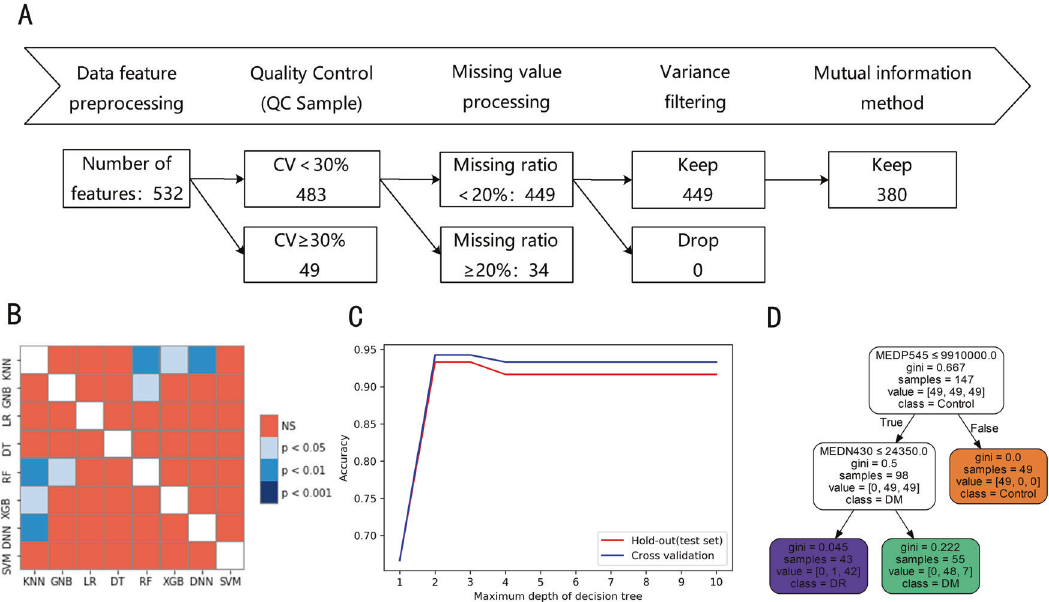
Fig. 1 Data preprocessing and selection of machine learning models. Metabolomic data preprocessing work fl ow ( A ), accuracy heat map of machine learning model ( B ), decision tree ( D ), and its hyper-parameter learning curve ( C ). Notes: C Maximum depth parameter (max_depth) selection in the decision tree model used hold-out and 10-fold cross-validation based on the hyper-parameter learning curve; D A decision tree model based on the training set to distinguish the healthy control group, DM group, and DR group. Abbreviations: QC quality control, CV Coef fi cient of variation, KNN K-Nearest Neighbors, GNB Gaussian Naive Bayes, LR Logistics Regression, DT Decision Tree, RF Random Forest, XGB XGBoost, DNN Neural Networks, SVM Support Vector Machine, MEDP545 2-pyrrolidinone, MEDN430 thiamine triphosphate, Control healthy control group, DR diabetic retinopathy group, DM diabetes mellitus without DR